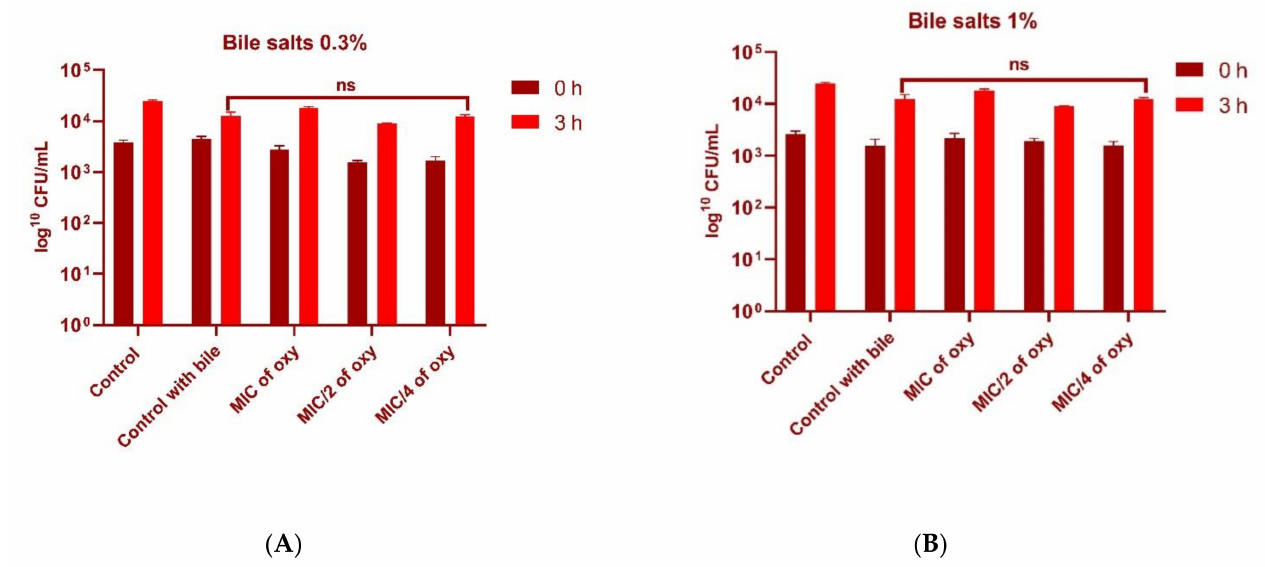
Figure 8. ( A ) Viable counts (log CFU/mL) of L. fermentum ASBT-2 after 3 h of exposure to 0.3% bile salts with MIC, MIC/2 and MIC/4 concentrations of oxyresveratrol. ( B ) Viable counts (log CFU/mL) of L. fermentum after 3 h of exposure to 1% bile salts with MIC, MIC/2 and MIC/4 concentrations of oxyresveratrol. L. fermentum ASBT-2 grown in MRS supplemented with bile salts without compound was maintained as control (control with bile). ns: